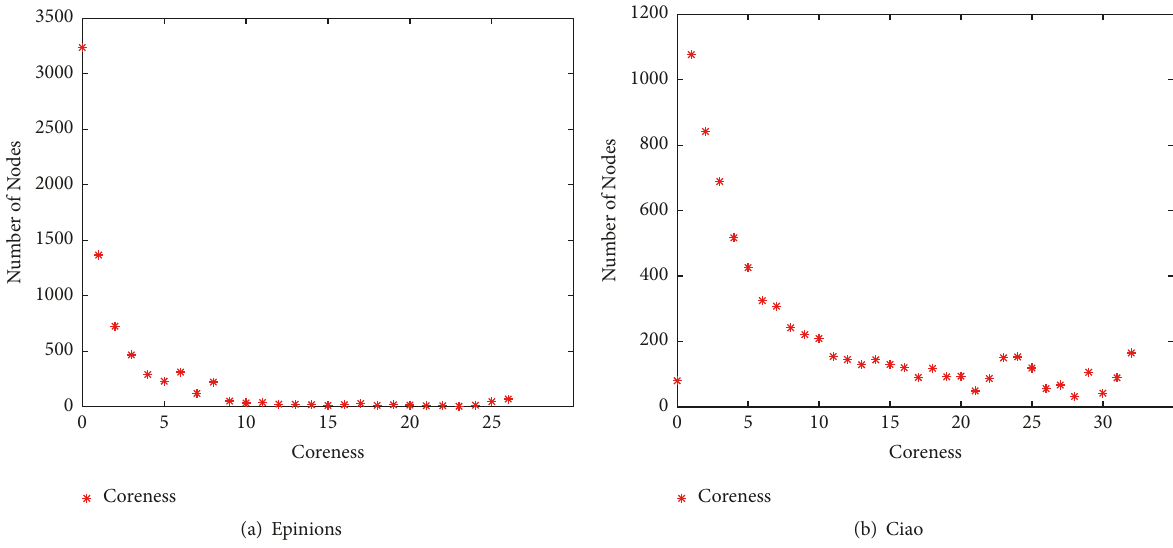
Figure 1: The distribution of coreness in different